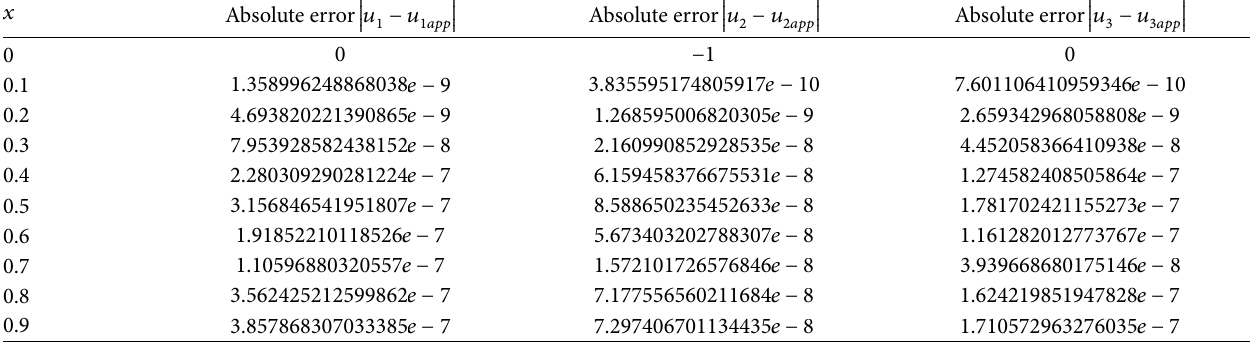
Table 2: The resulting error for the numerical solution.